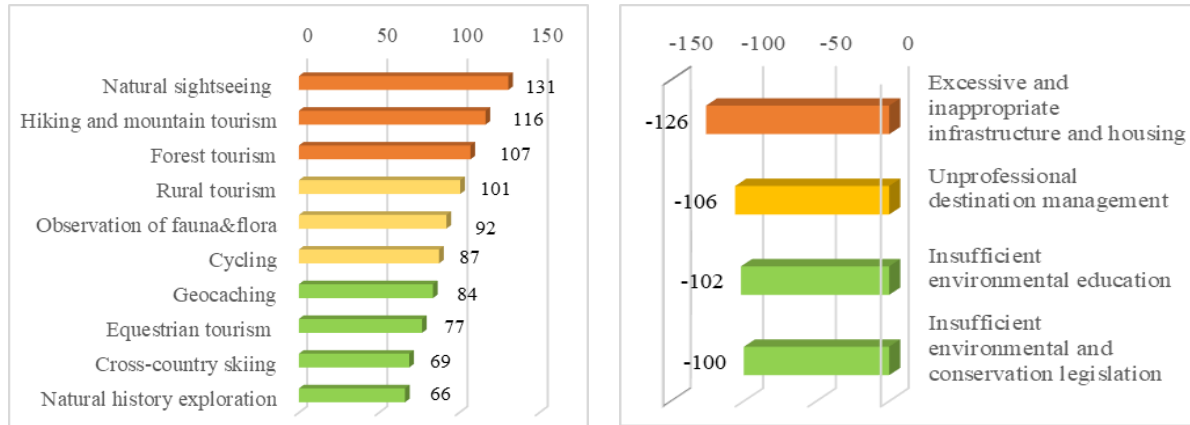
Fig. 2. Scheme of the methodology, author’s own elaboration